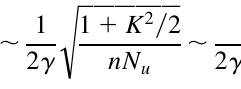
2 mm (inset). Measured peak values of the field B for the finite probe size of 0.75 mm diameter by 6% (rhombs), are compared to simulation results (CST EM Studio, open circles) as a function of the gap height g . The line shows a double exponential fit according to Ref.